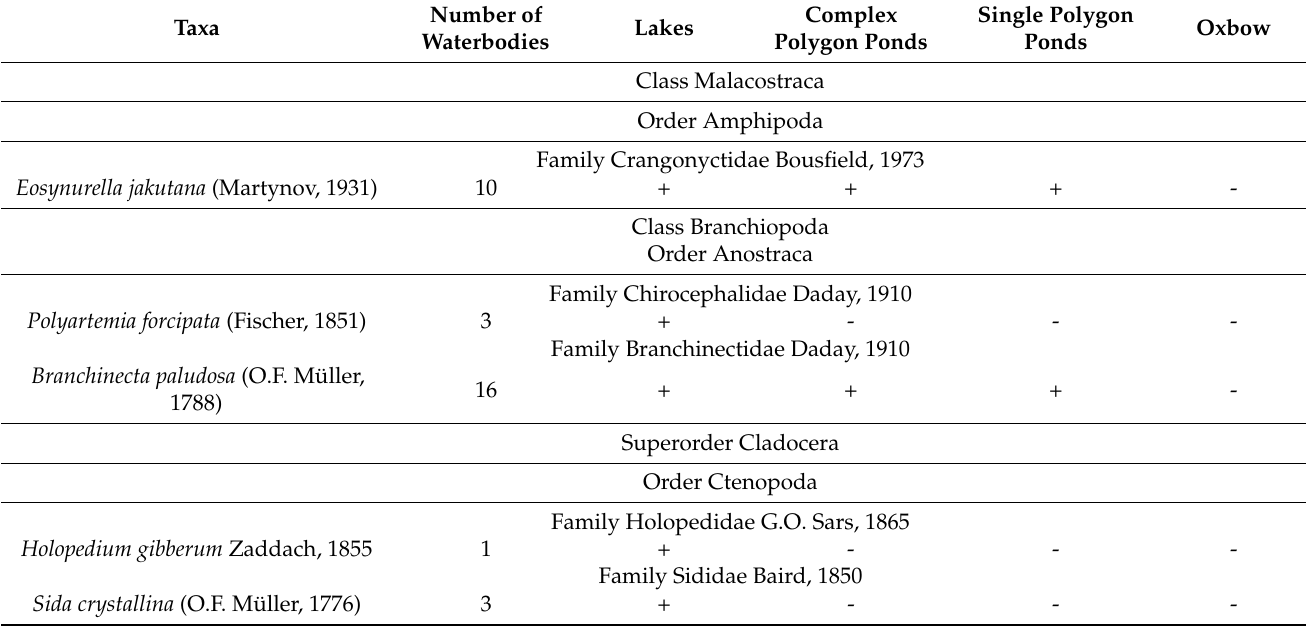
Table 1. Species list and presence of crustaceans from plankton and meiobenthos in water bodies of Kurungnakh and Argaa-Bilir-Aryata Islands (southern part of the Lena River Delta) in July–August 2017 and 2020 (*–species noted for the first